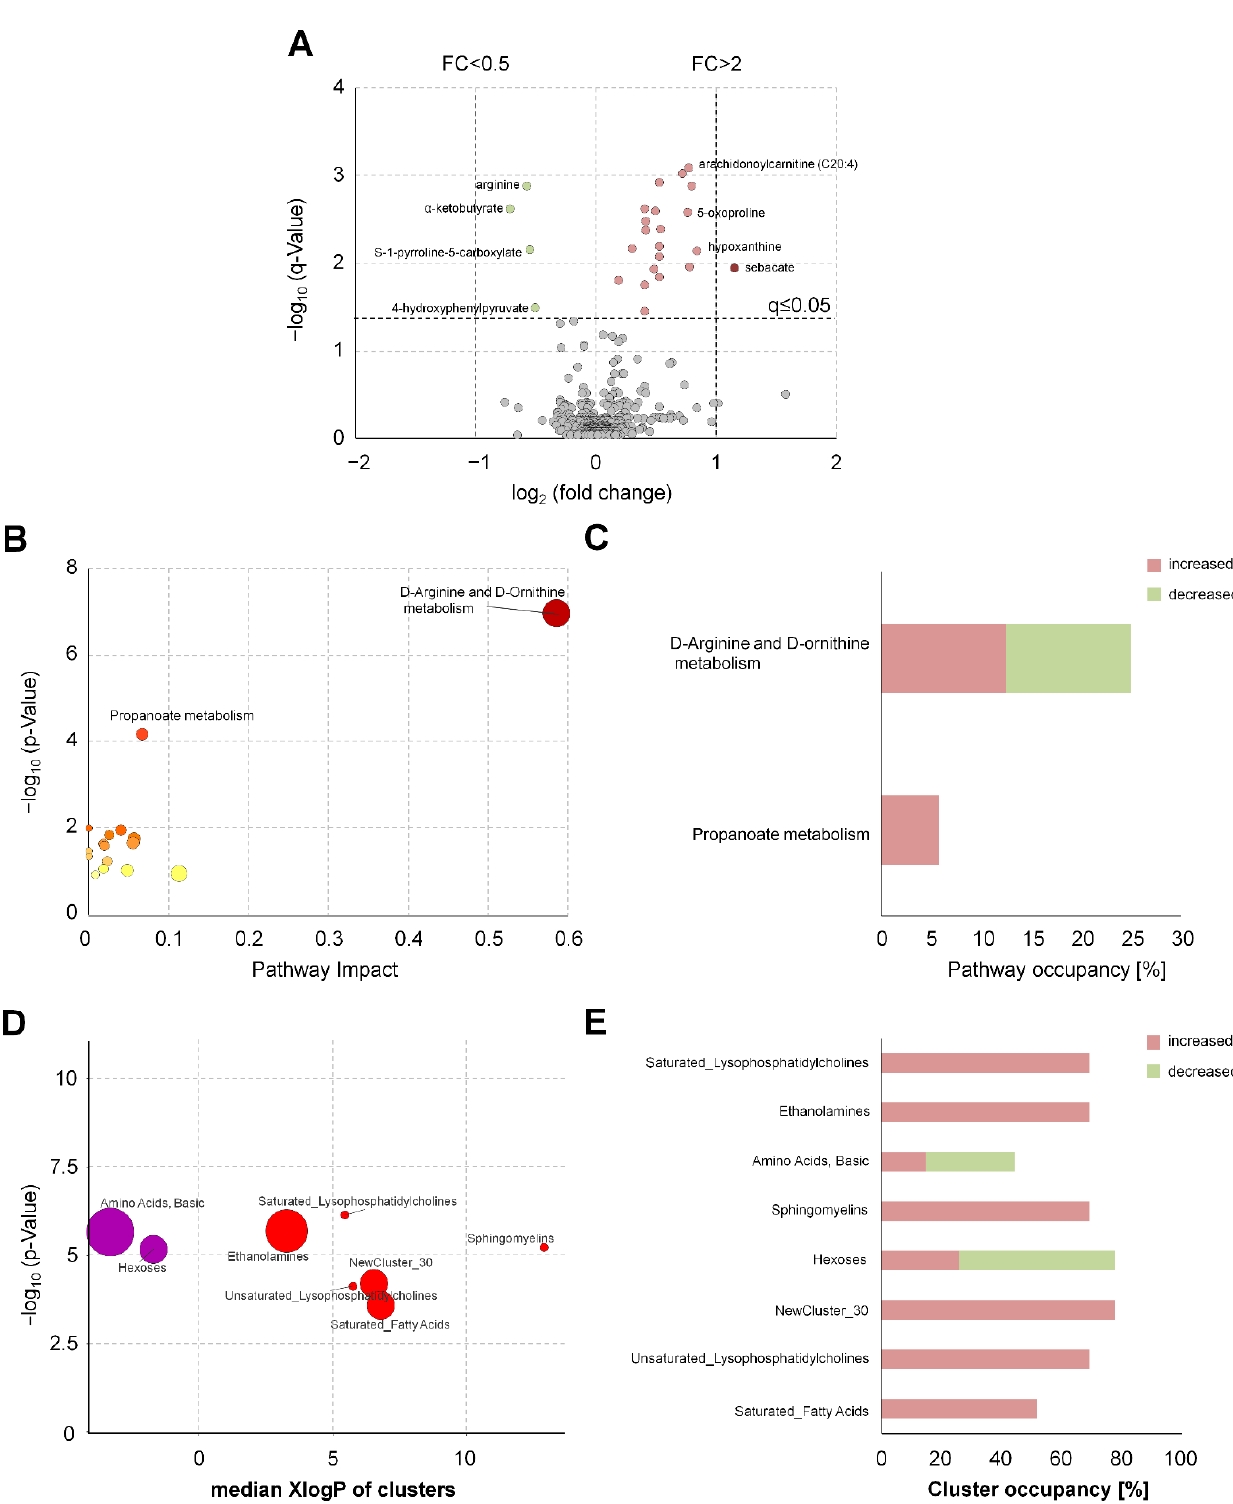
Figure 2. Chemical similarity and pathway enrichment analysis to identify novel QIs for the precentrifugation delay in human EDTA plasma. ( A ) Volcano plot of serum metabolites visualizes the effects of prolonged blood incubation after 2 h before centrifugation. Red (increase) and green (decrease) circles indicate altered metabolite levels ( discovery sample , n = 10). A paired t -test was performed, and we applied addressed multiple testing by deriving q-values to control the positive false discovery rate. ( B ) Represents the pathway enrichment analysis using the altered metabolites of ( A ). Node size